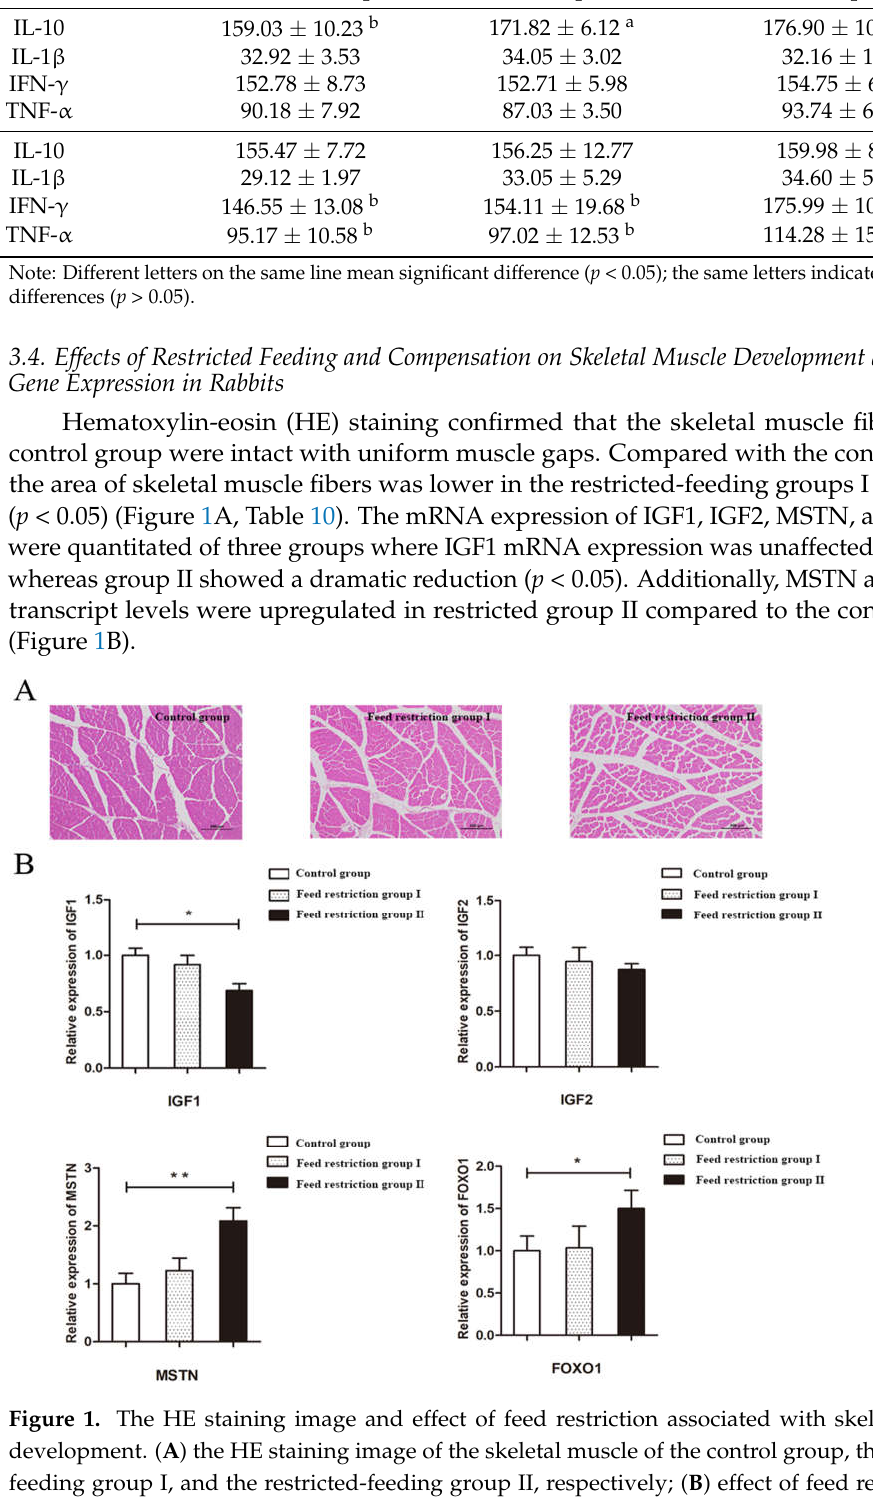
Figure 2. Effect of feed restriction on the phosphorylation level of Akt and p70. ( A ) the Akt, p-Akt, and GAPDH protein expressions in different groups; ( B ) the p70, p-p70, and GAPDH protein ex- pressions in different groups.